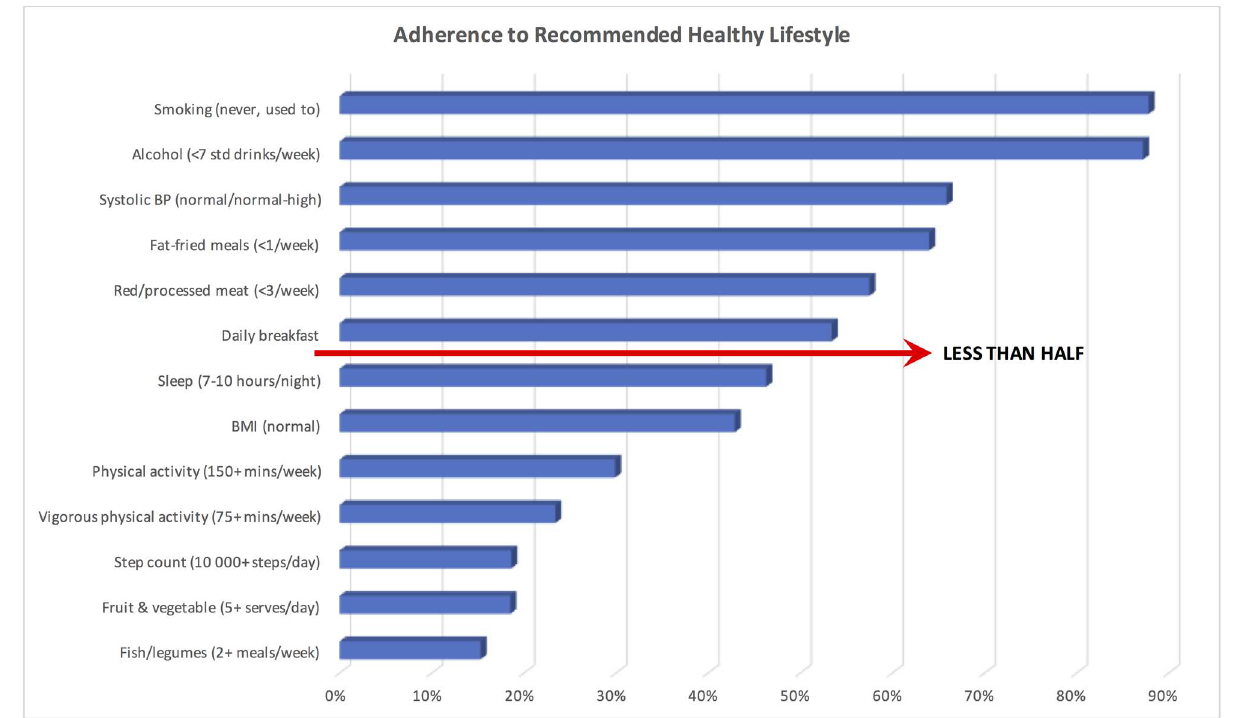
Fig 3. Rate of compliance with recommended health guidelines.